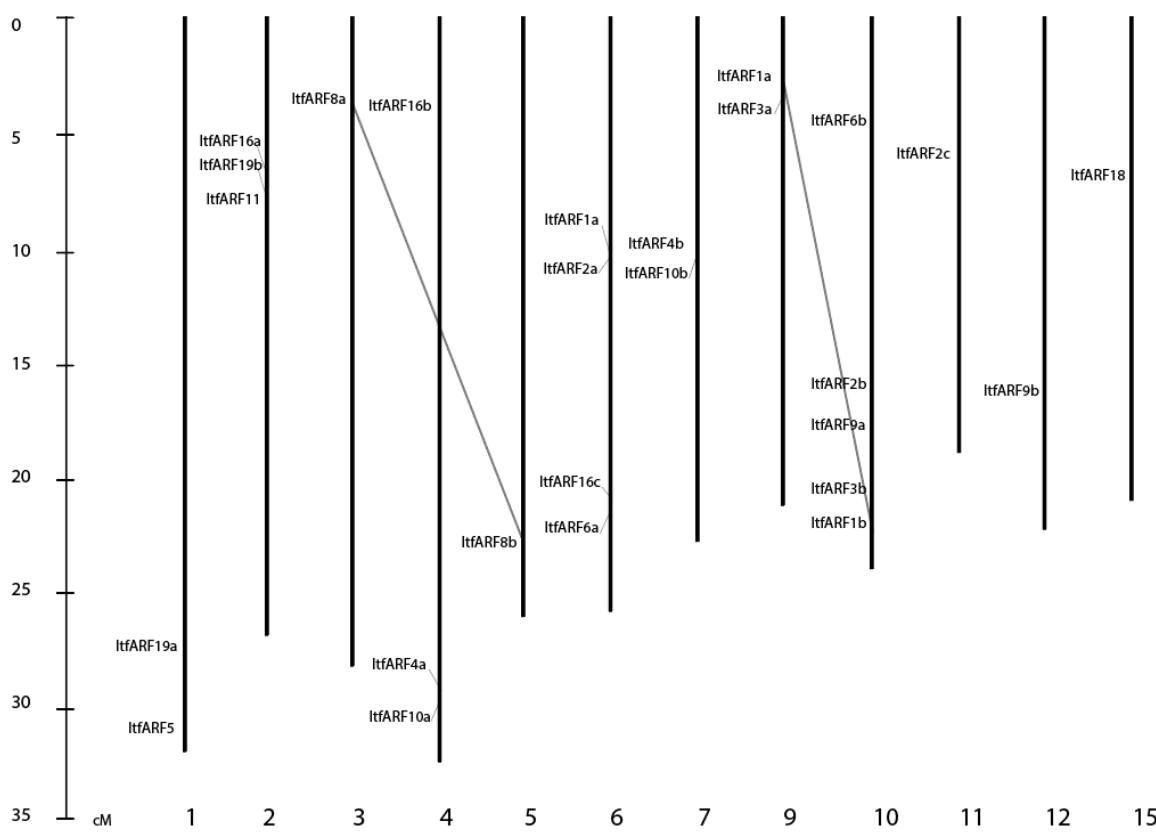
Figure 2. Chromosomal distribution of ARF genes in I. trifida , spanning 12 of the 15 chromosomes, gene duplication analysis of ItfARF was presented with a gray line.